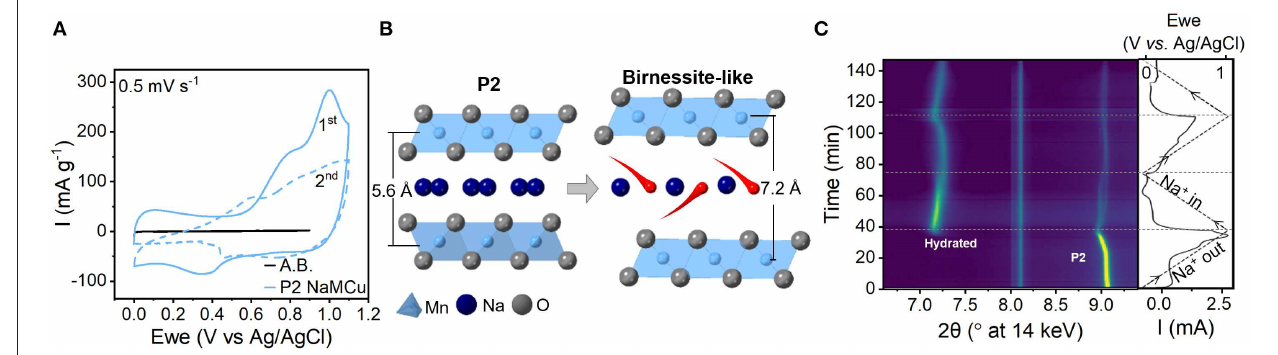
FIGURE 1 | Mechanism of water intercalation into P2-type NaMCu upon electrochemical cycling in 1M Na 2 SO 4 . (A) Cyclic voltammetry at 0.5 mV/s. A.B. indicates “acetylene black,” the electrochemical response of the conductive carbon in the electrode. (B) Cartoon showing the insertion of water molecules (red) from the electrolyte into the material interlayer to compensate for the electrochemical de-intercalation of Na + (dark blue). (C) Operando synchrotron XRD during the first two CV cycles at 0.5 mV/s. The right-most panel shows the applied potential (dashed line) and the current response (solid line). During the first anodic cycle, the interlayer peak of the hydrated birnessite-like phase ( ∼ 7 ◦ 2 θ ) emerges around 0.9V. Both the P2 and the hydrated peak show reversible, continuous changes in the interlayer spacing as a function of potential attributed to Na + de/intercalation. The peak at 8.1 ◦ 2 θ is due to the electrochemical